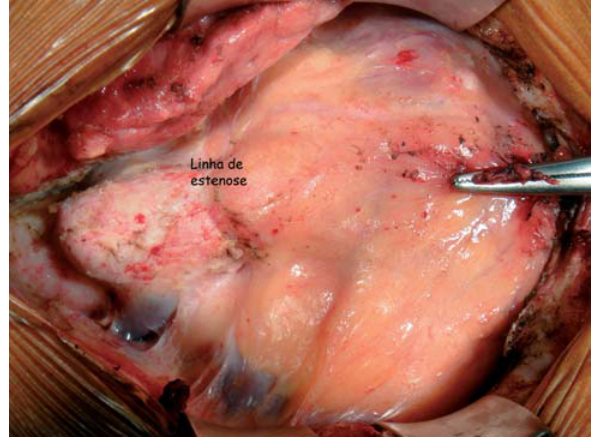
Fig. 5 / Vídeo 1 (http://www.rbccv.org.br/video/v25n3/) – Após esternotomia e dissecção das aderências localizando o local de estenose no tronco pulmonar. No vídeo pode-se notar indiretamente o frêmito palpável durante a